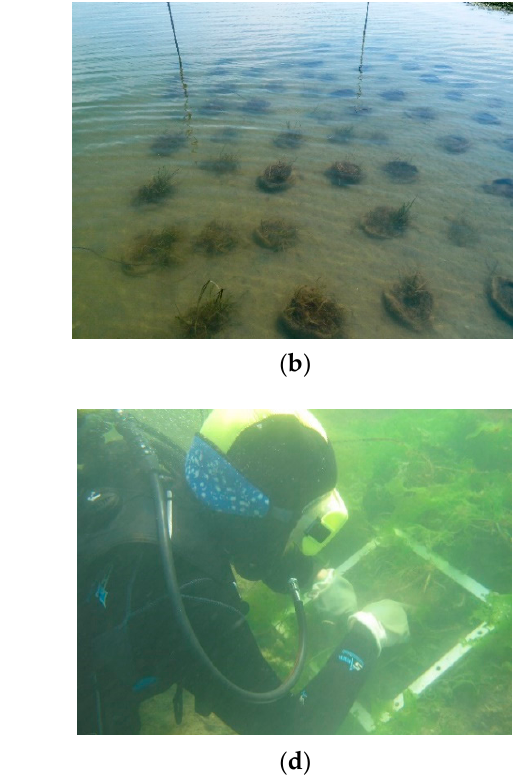
Figure 3. Manual seagrass transplantation: ( a ) replanting of the sods in the sediment, ( b ) transplanted sods, ( c ) rhizome colonizing the bare sediment adjacent to the transplantation area and ( d ) seagrass growth monitoring.